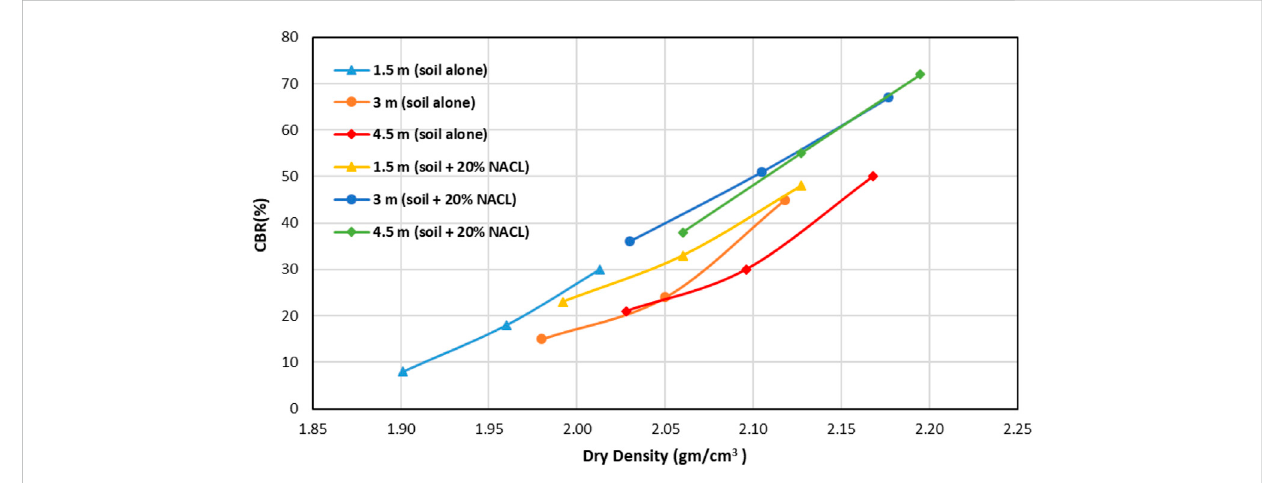
FIGURE 9 CBR versus dry density for untreated soil and treated with 20% NaCl at different